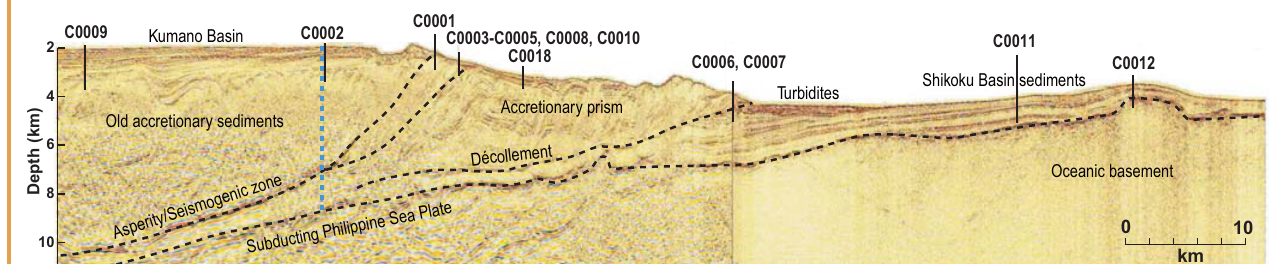
Figure 2. Spliced composite profile of a representative depth section from the NanTroSEIZE 3D seismic data volume (Moore et al., 2009) and Line 95 from IFREE mini-3D seismic survey (Park et al., 2008). Projected positions of Stage 1 and 2 drilling sites, including C0009, C0010, C0011, and C0012.